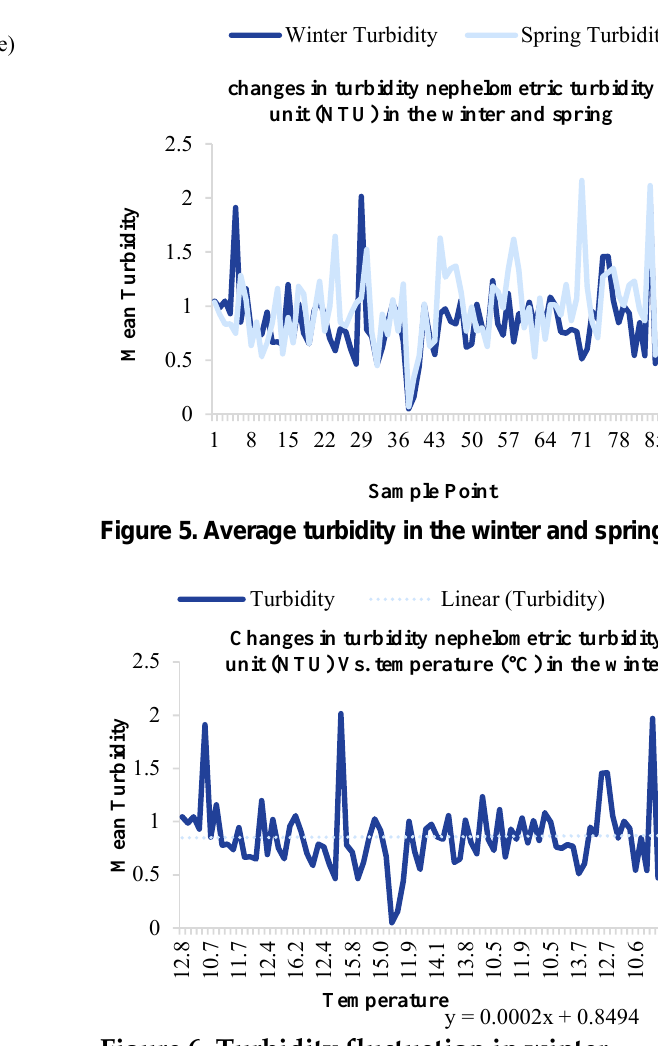
Figure 6. Turbidity fluctuation in